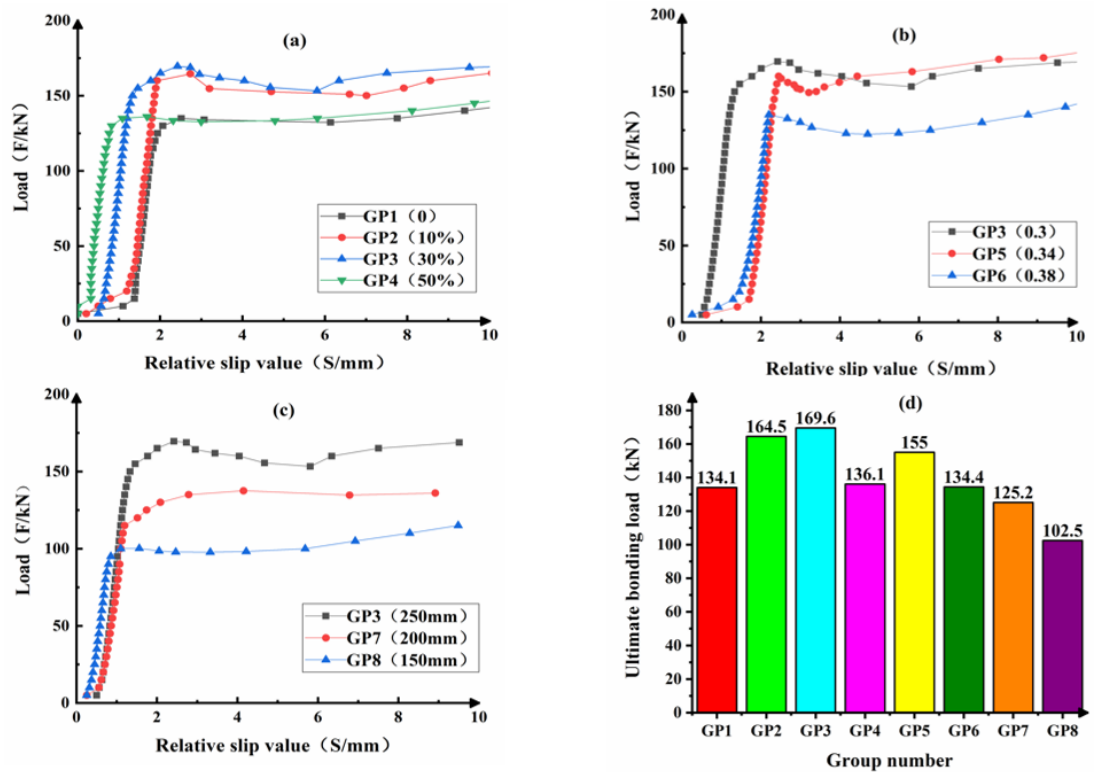
Figure 5. Load-slip curves of CFST ( a ) different dosage of CFB-BA ( b ) different W/B ( c ) different bonding length ( d ) ultimate bonding load.